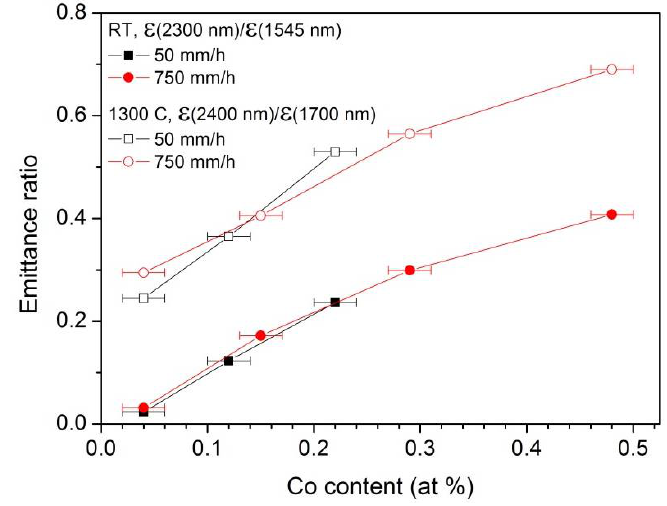
Figure 11. Ratio of emittances at 2300 nm vs. 1545 nm at room temperature (filled symbols), and at 2400 nm vs. 1700 nm at 1300 °C (open symbols). With black symbols, eutectic bar-samples solidified at 50 mm/h, with red symbols, samples solidified at 750 mm/h. Emittance at 1300 °C estimated as the thermal emission intensity divided by the black body profile.